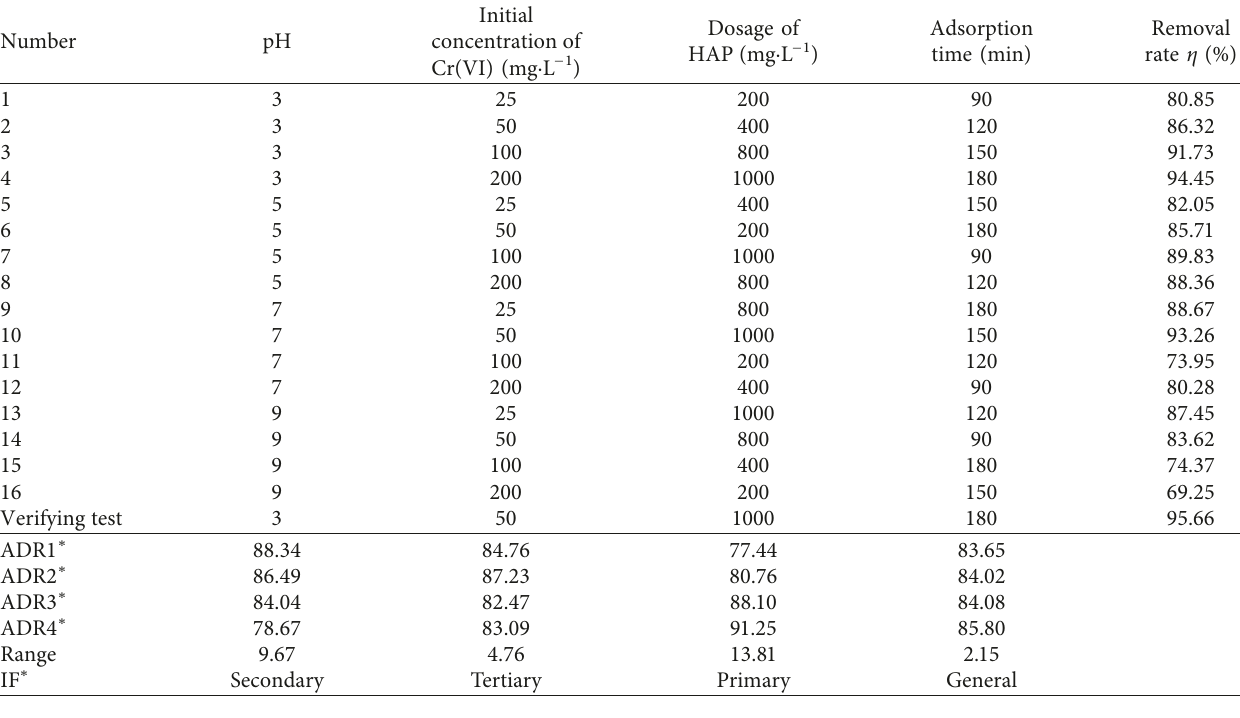
Table 2: Orthogonal experimental design and results.